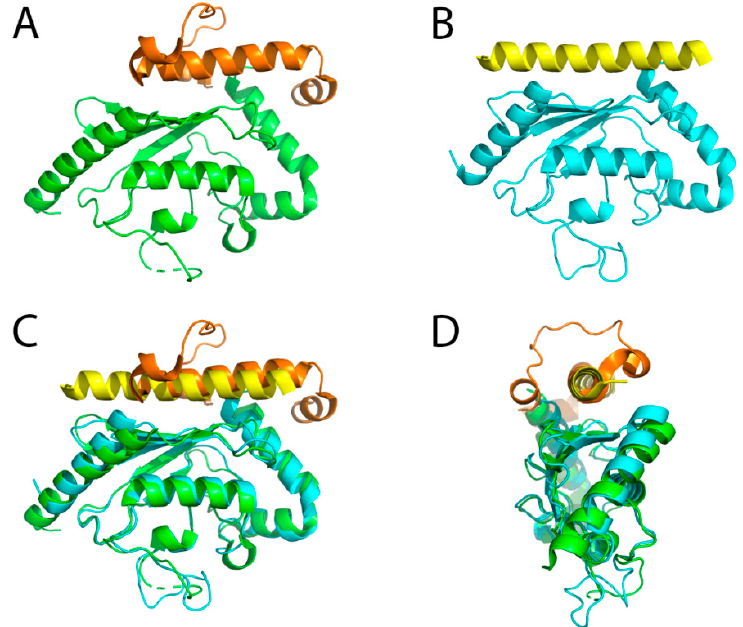
Figure 2. Crystal structures of E2 enzymes in complex with the U7BR/G2BR domains. ( A ) Yeast Ubc7 in complex with U7BR (PDB ID: 4JQU). The green and orange colors represent Ubc7 and U7BR, respectively; ( B ) Mammalian Ube2g2 in complex with G2BR (PDB ID: 3H8K). The cyan and yellow colors represent Ube2g2 and G2BR, respectively; ( C ) Superimposed structures of ( A , B ); ( D ) Superimposed structures of ( A , B ), rotated 90 ◦ along the vertical axis compared to ( C ). In both cases the binding domain interacts with the backside of the E2 enzyme, opposite from the catalytic cysteine.